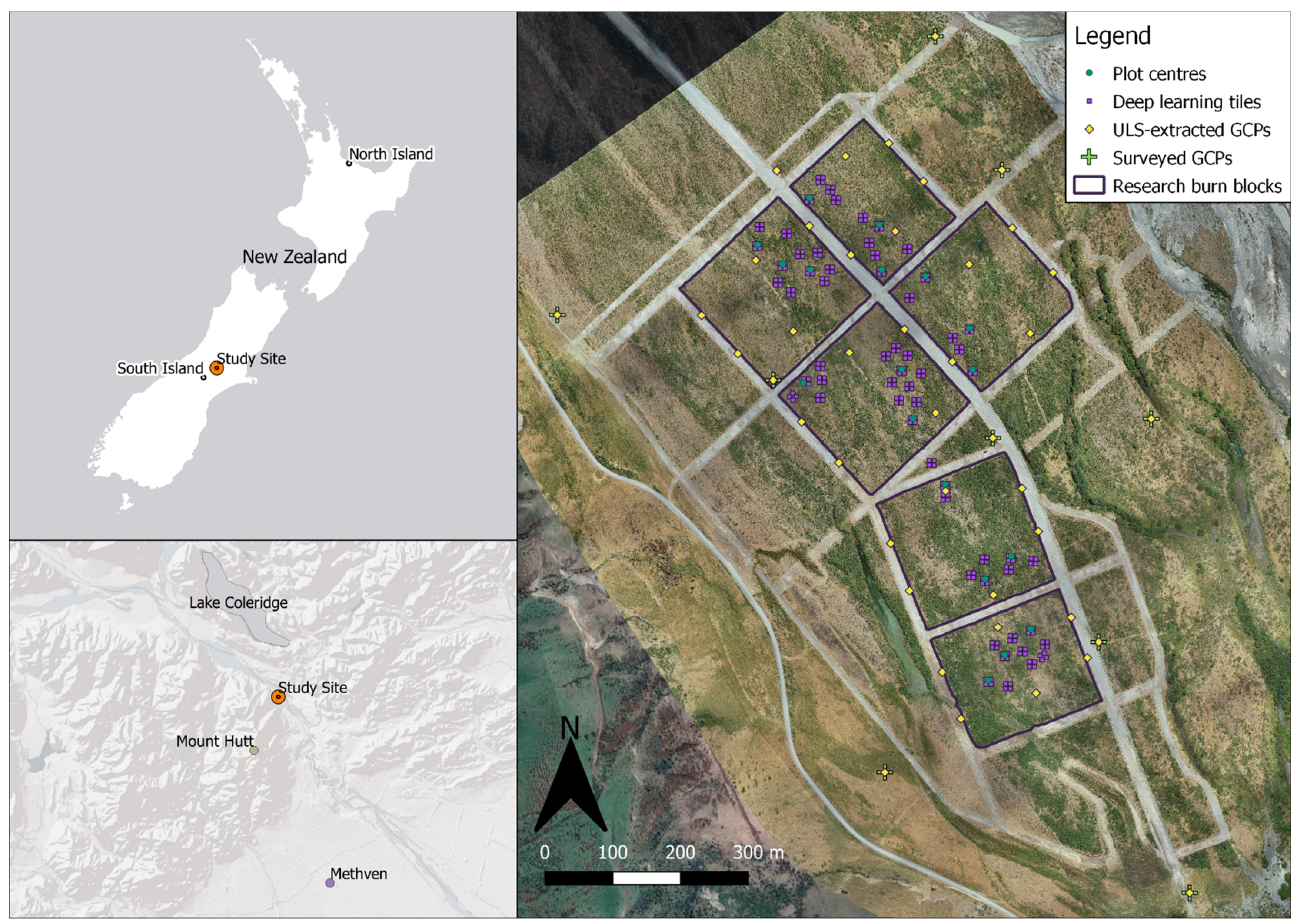
Figure 1. Map of the study site showing location of GCPs, plots, deep learning tiles and burn blocks. Inset maps show the site location.